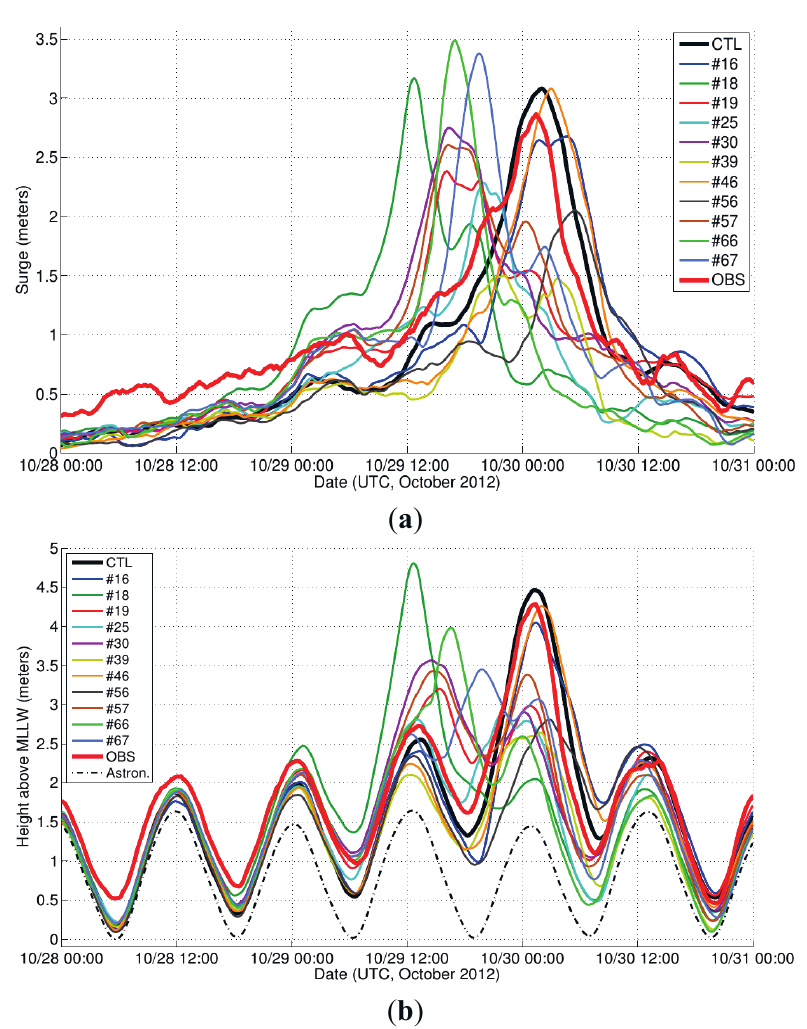
Figure 4. ( a ) Storm surge (in meters) at The Battery, NYC for the observed (bold red), control WRF-ADCIRC member (bold black), and 11 ensemble WRF-ADCIRC members (see legend) from 00:00 UTC, 28 October 2012, to 00:00 UTC, 31 October; ( b ) Same as ( a ) except for the total water level (surge + tide) in meters above mean lower low water (MLLW; 1.0 m;